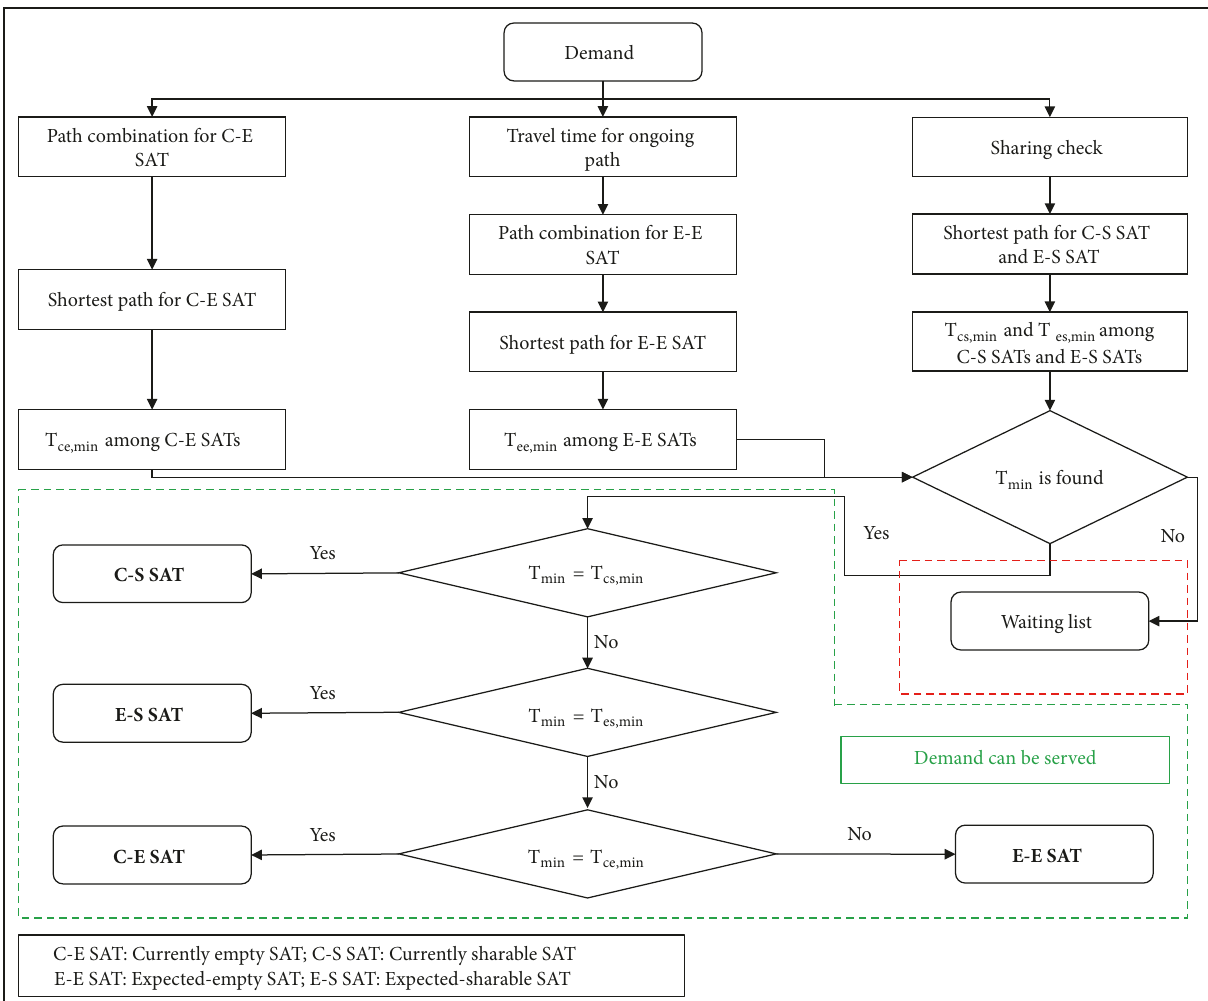
Figure 4: SAT assignment